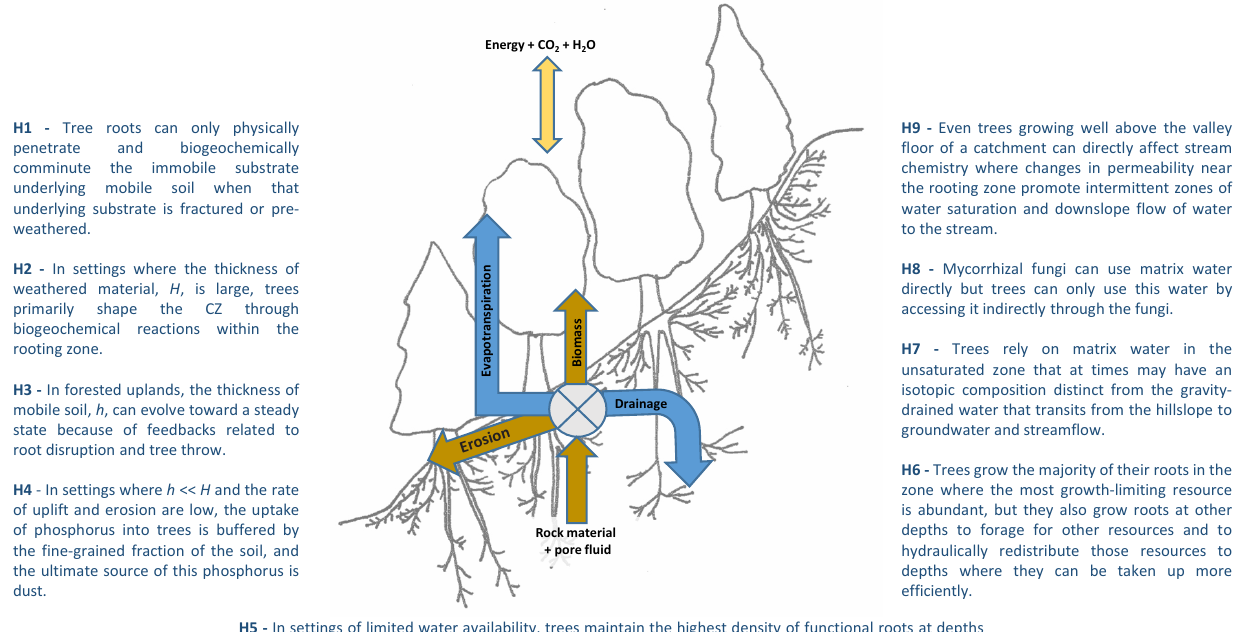
Figure 1. Trees transform energy + CO 2 + H 2 O ( + nutrients) into biomass at the same time that they affect water fluxes, climate, erosion, weathering, hillslopes, distribution of elements and microbiota in soils. Nine hypotheses are proposed about these inter-relationships for future testing. As energy from the sun radiates on to the earth at about 800Wm − 2 , trees act like power plants that transform energy (into biomass) and flush water (transpiration). A single tree can transpire on the order of 100kgwaterday − 1 . The trees and their roots are shown with the symbol for a valve ( ⊗ ) to emphasize that trees act to partition water into the atmosphere (evapotranspiration), into throughfall, into stemflow, and into the subsurface where water can flow along roots and macropores (see text). At the same time that water is removed from soil and transpired, tree roots embed themselves in the soil and stabilize its structure. As the tree and its associated microbiota inject acids and other exudates into the soil, nutrient material is solubilized, taken up into the tree, and then returned to the soil after the leaves fall or the tree dies. Likewise, after dying on hillslopes, tree fall can lift the rock material in the root wad, moving it toward the earth’s surface and then downhill. Over much longer timeframes, such bioturbation moves soil downslope. In these ways, trees act as stirring agents, moving nutrients and particles from rooting depth to land surface through chemical and mechanical processes,